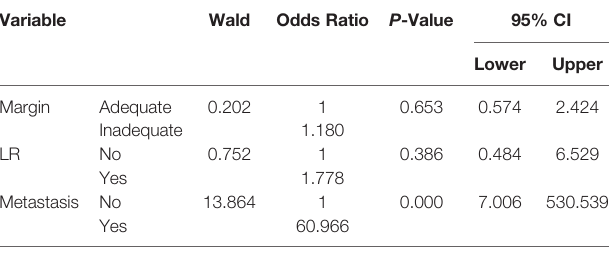
TABLE 4 | Outcomes in Multivariate Analysis of Prognostic Factors. Variable